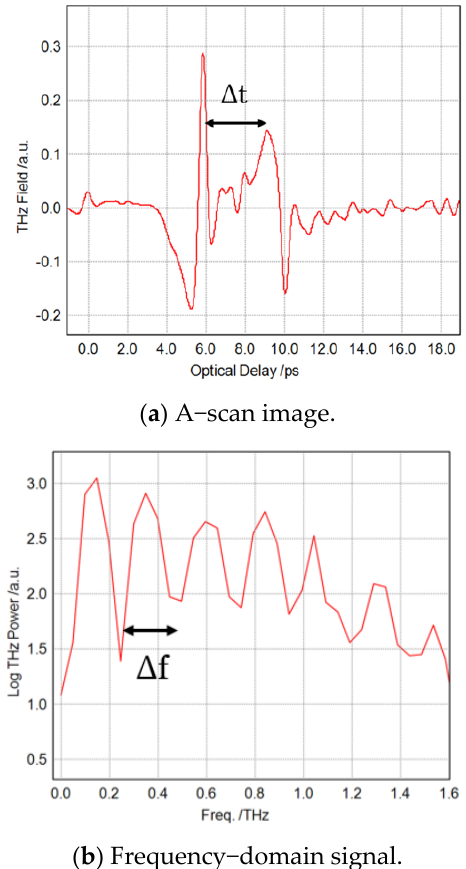
Figure 7. A TOF and FFT image of the thin Shim stock films under the reflection mode (0.381 mm in thickness).